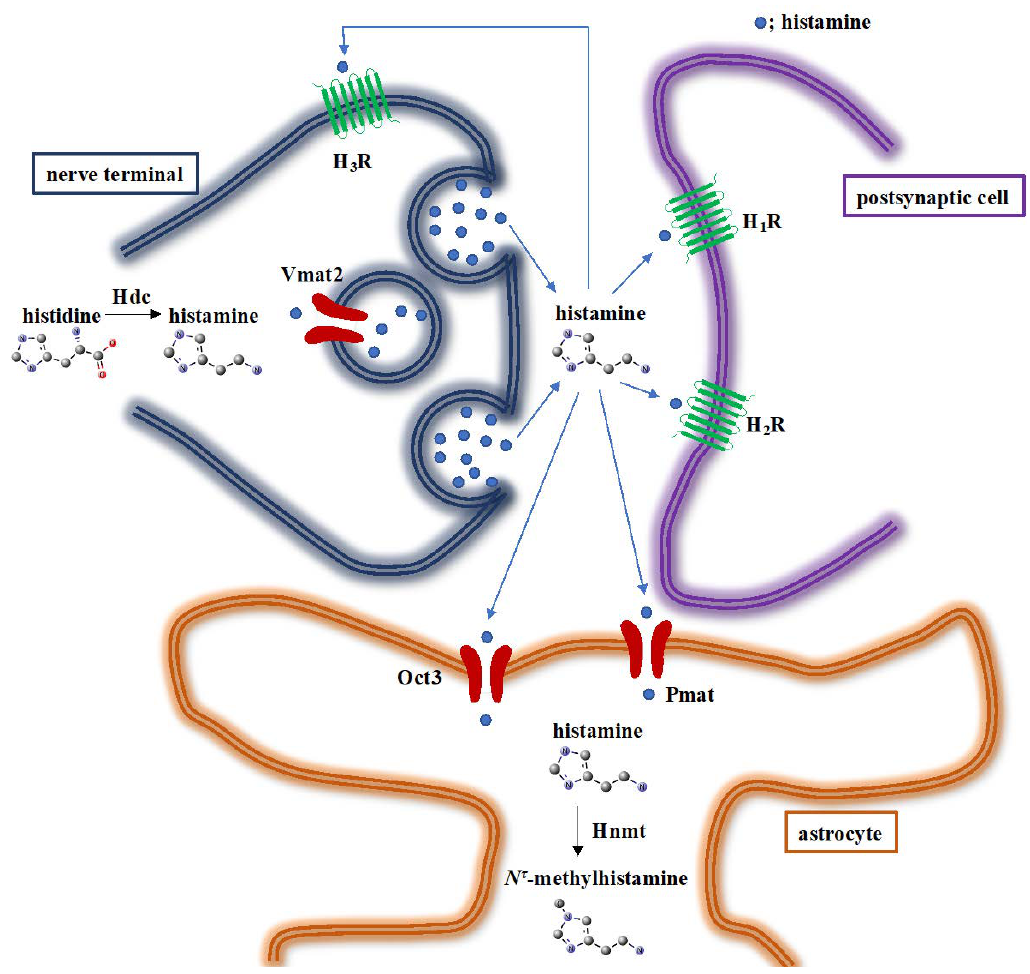
Figure 1. Neurotransmission and termination of histaminergic nervous system. Histidine decarboxylase (Hdc) synthesises histamine from histidine. Histamine is stored in synaptic vesicles via